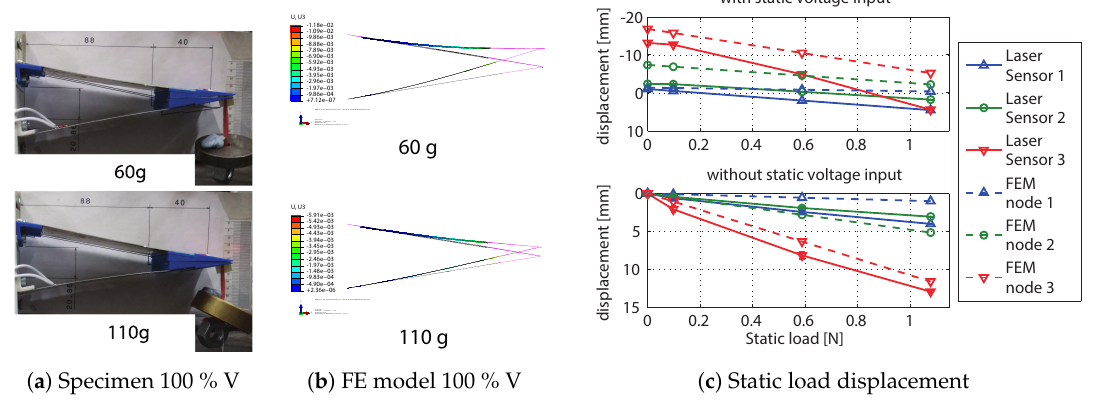
Figure 9. Actuator static load test.